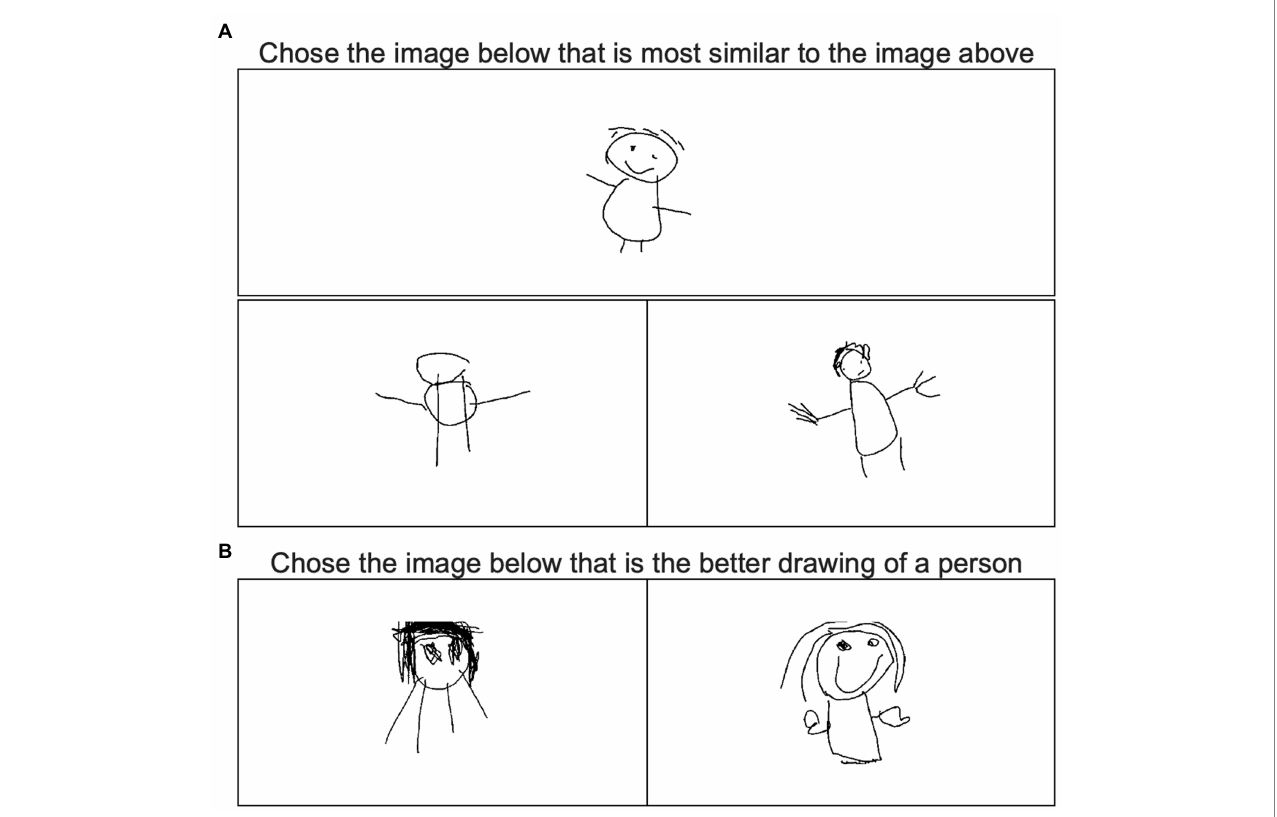
FIGURE 4 Examples of trials in human-judgment tasks. (A) One trial of the triadic judgement task where participants must decide which of the two bottom images is most perceptually similar to the top image. (B) One trial of the drawing quality judgment task, in which participants must decide which of two images is a better drawing of a